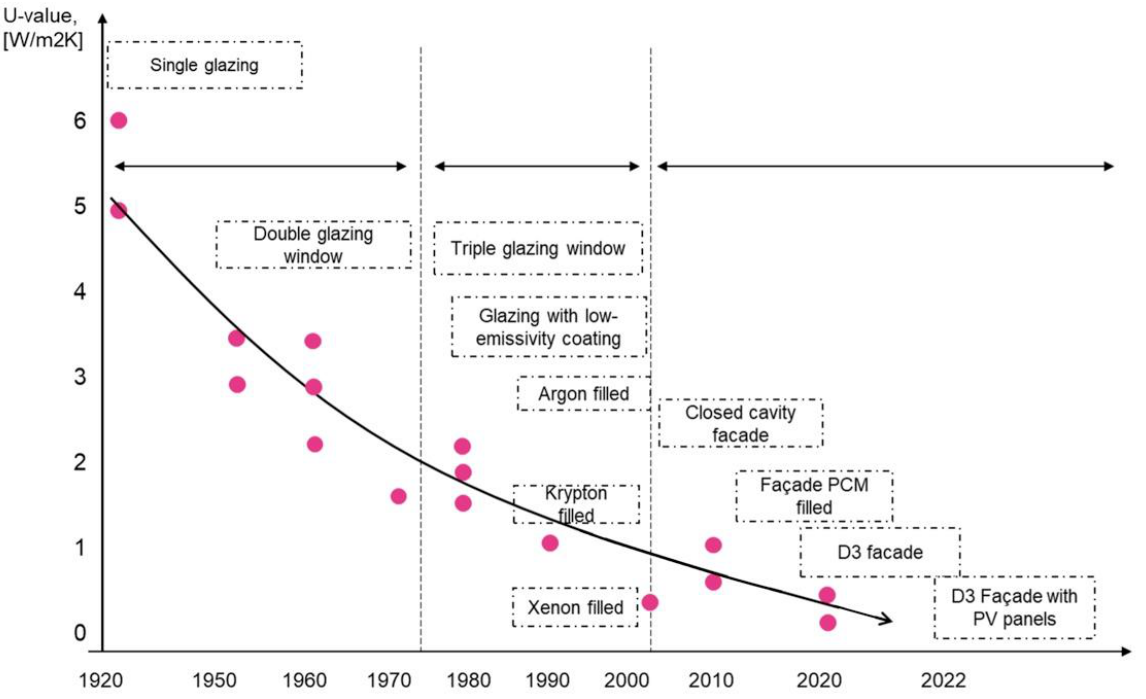
Figure 1. Development U-value of window and glazing façade.